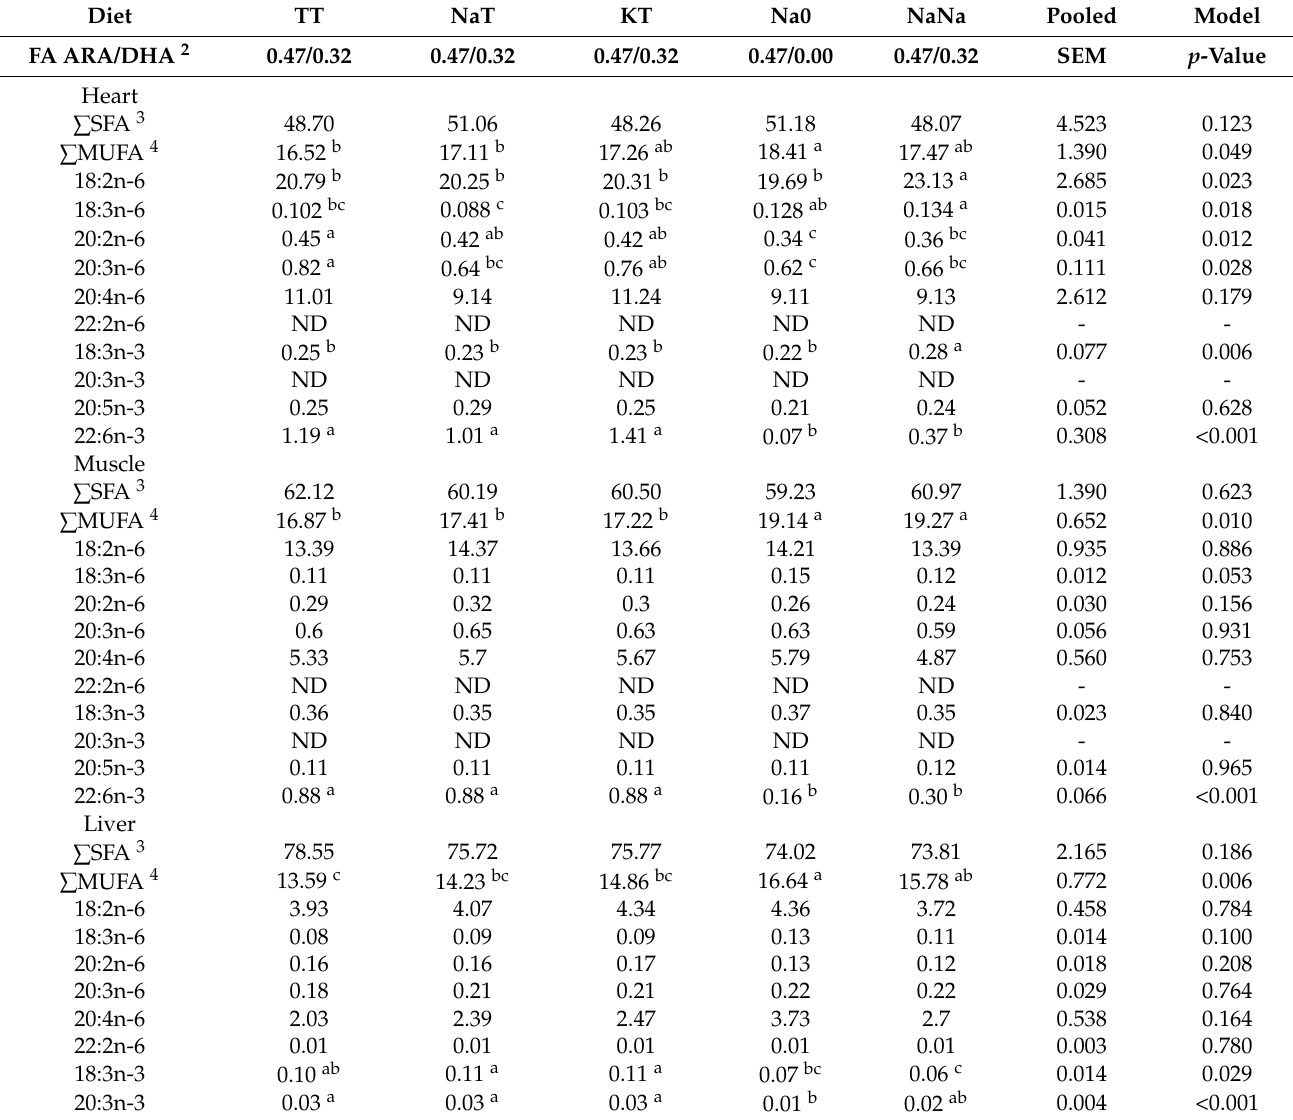
Table 7. Select heart, muscle, and liver FA concentrations of pigs receiving experimental milk replacers with different sources of ARA (% of total measured FA) 1